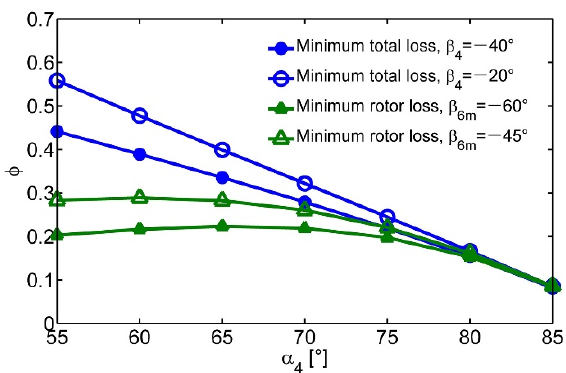
Figure 4. Effect of guide vane outlet flow angle on the optimal flow coefficient value. Figure 4. E ff ect of guide vane outlet flow angle on the optimal flow coe ffi cient